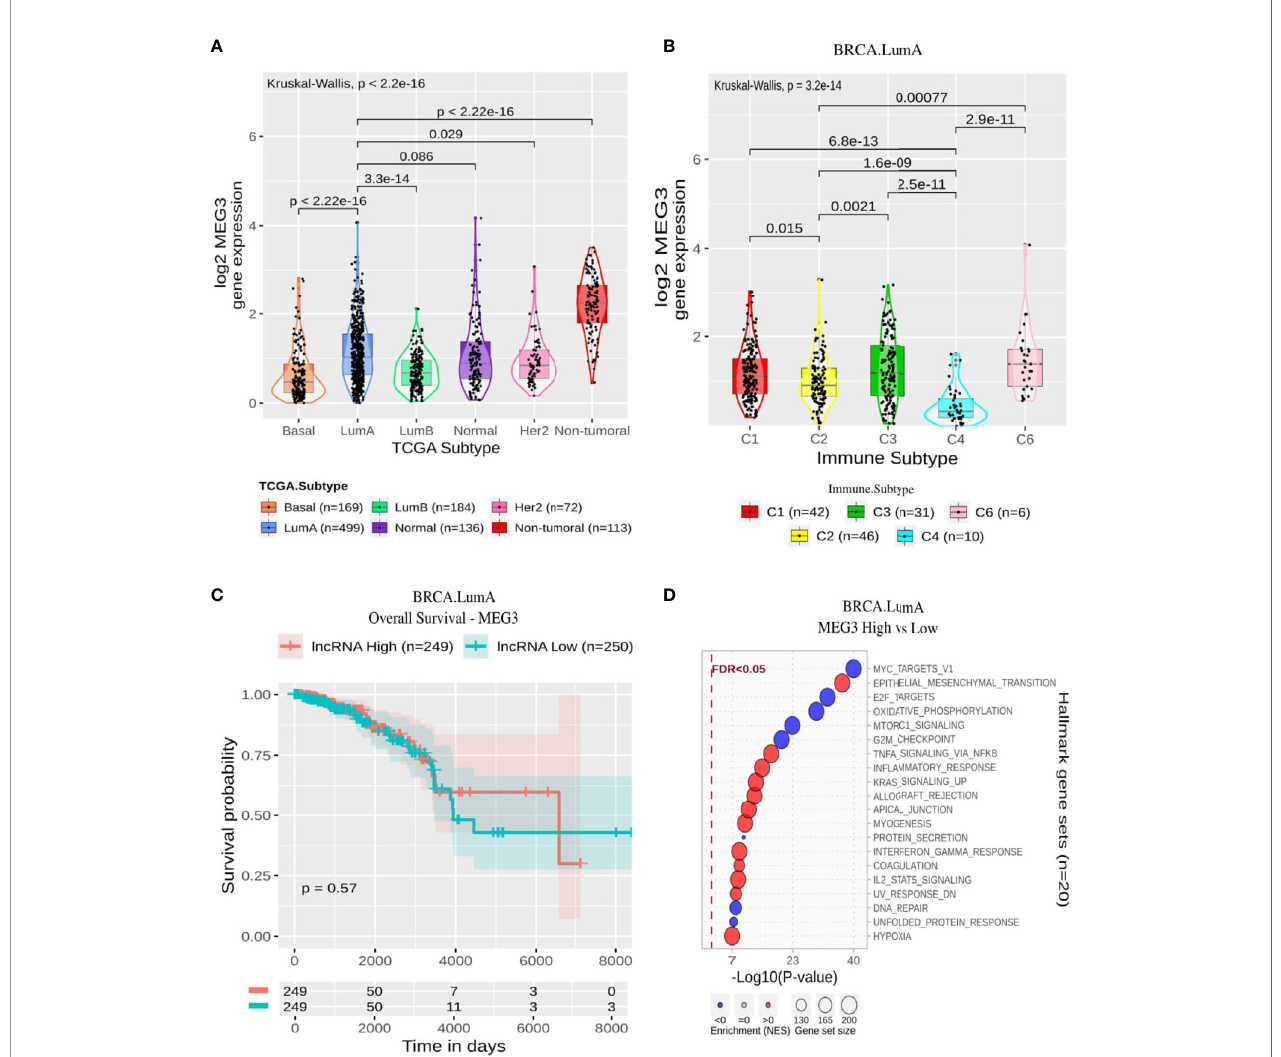
FIGURE 6 | MEG3 panel representation in LumA subtype. (A) Box-plots representing MEG3 expression among all breast cancer molecular subtypes. The Kruskal- Wallis test (p-value represented in the panel left top position) was used to differentiate expression between groups, followed by the Wilcoxon test (p-values represented emphasizing comparisons between subtypes). (B) Box-plot representing MEG3 in C1,C2, C3, C4, and C6 immune subtypes in LumA patients. (C) MEG3 overall survival curves. To de fi ne the two groups, MEG3 ’ s median expression classi fi ed the patients into “ high ” and “ low ” groups. Logrank p-value represented as 0.57. (D) Enrichment analysis using Hallmarks gene sets. Red circles refers to activation while blue circles to inactivation. In X axis, a p-value scale is represented. The circle size varies according to the number of genes in the identi fi ed gene